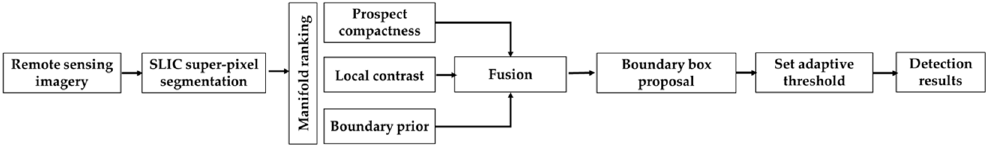
Figure 4. The flowchart of saliency model for building detection.